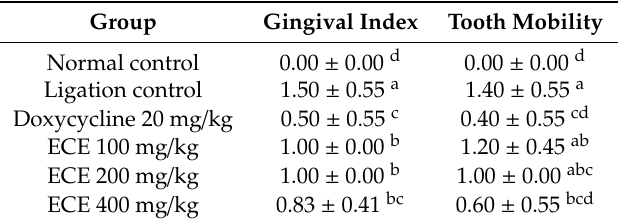
Table 1. E ff ect of Ecklonia cava ethanol extract (ECE) administration on gingival index and tooth mobility in ligature-induced periodontitis in